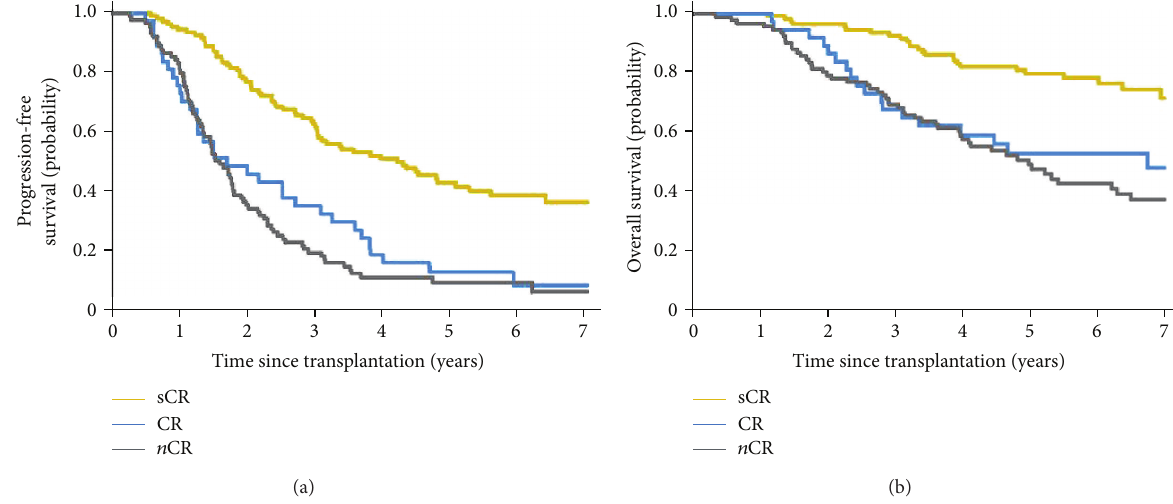
Figure 2: sCR is associated with superior PFS and OS compared to CR (adapted from